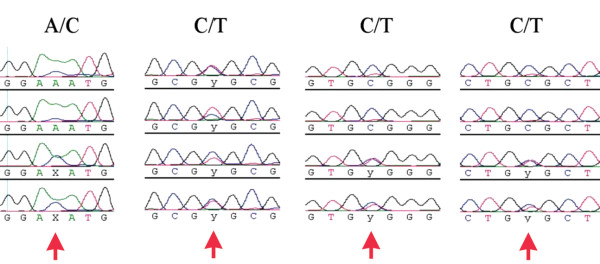
The assessment of hybrid status from heterozygosity of informative characters. The sequence traces were obtained from four F1 hybrid animals between Cottus perifretum and C. rhenanus. Four positions where fixed differences were known to occur are selected. Double peaks are evident in most, although not in all cases (see text).